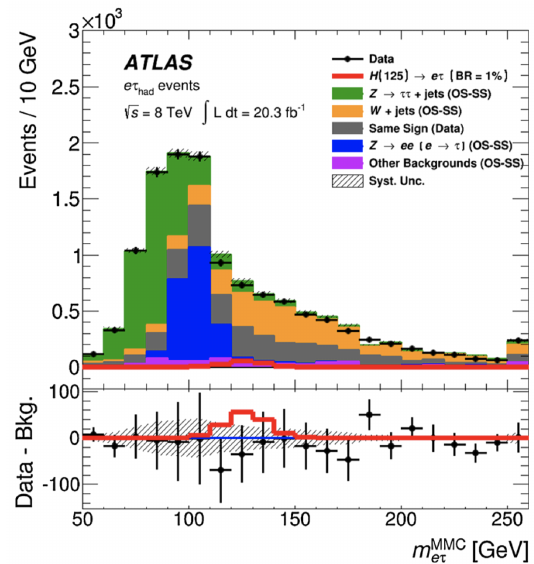
Figure 4: Post-fit combined m distribution in the e τ channel obtained by MMC had adding individual distributions in two signal regions. In the lower part of the fig- ure, the data are shown after subtraction of the estimated backgrounds. The signal is shown assuming B ( H → e τ ) = 1.0%. [ 13